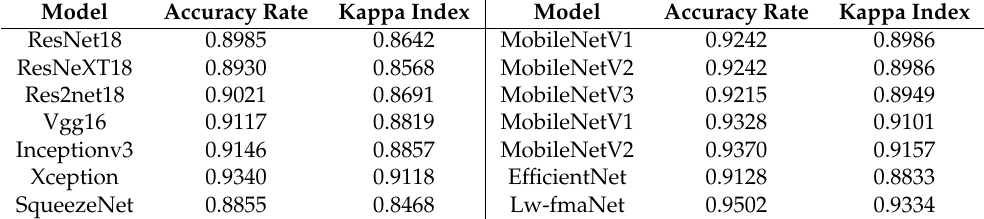
Table 4. Accuracy and Kappa index of each cloud and snow recognition